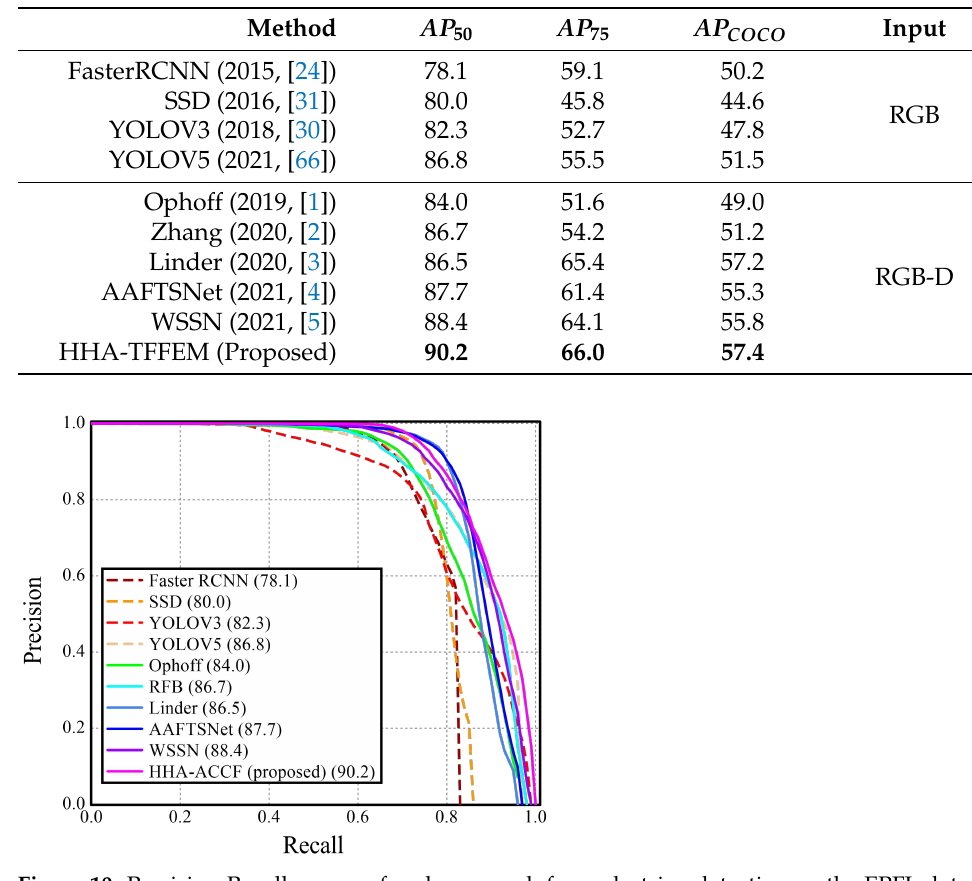
Figure 10. Precision-Recall curves of each approach for pedestrian detection on the EPFL dataset, where the dashed line indicates that the approach uses only RGB